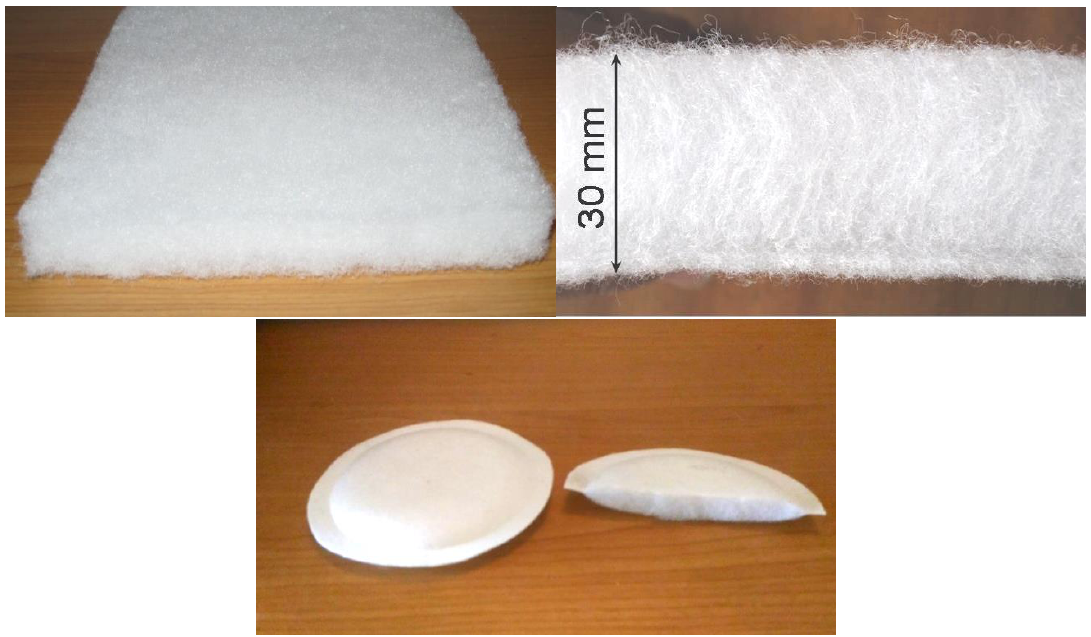
Figure 14. View on the cut of the struto textile, Elastic Universal, from JILANA, PLC, and the example of a filtration filler of the respirators made from struto textile and PVDF nanofibers membrane.